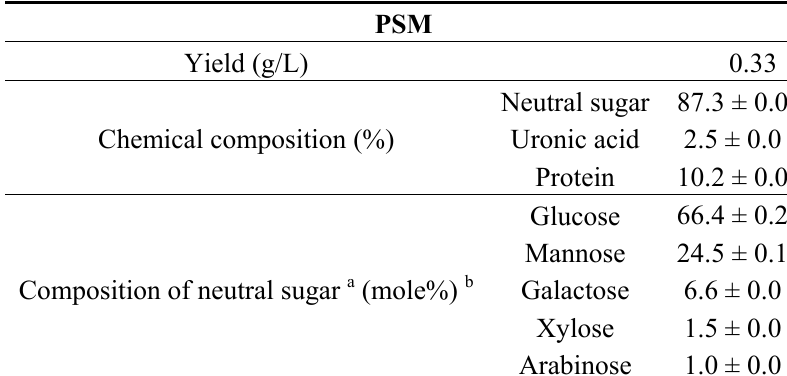
Table 1. The chemical composition of